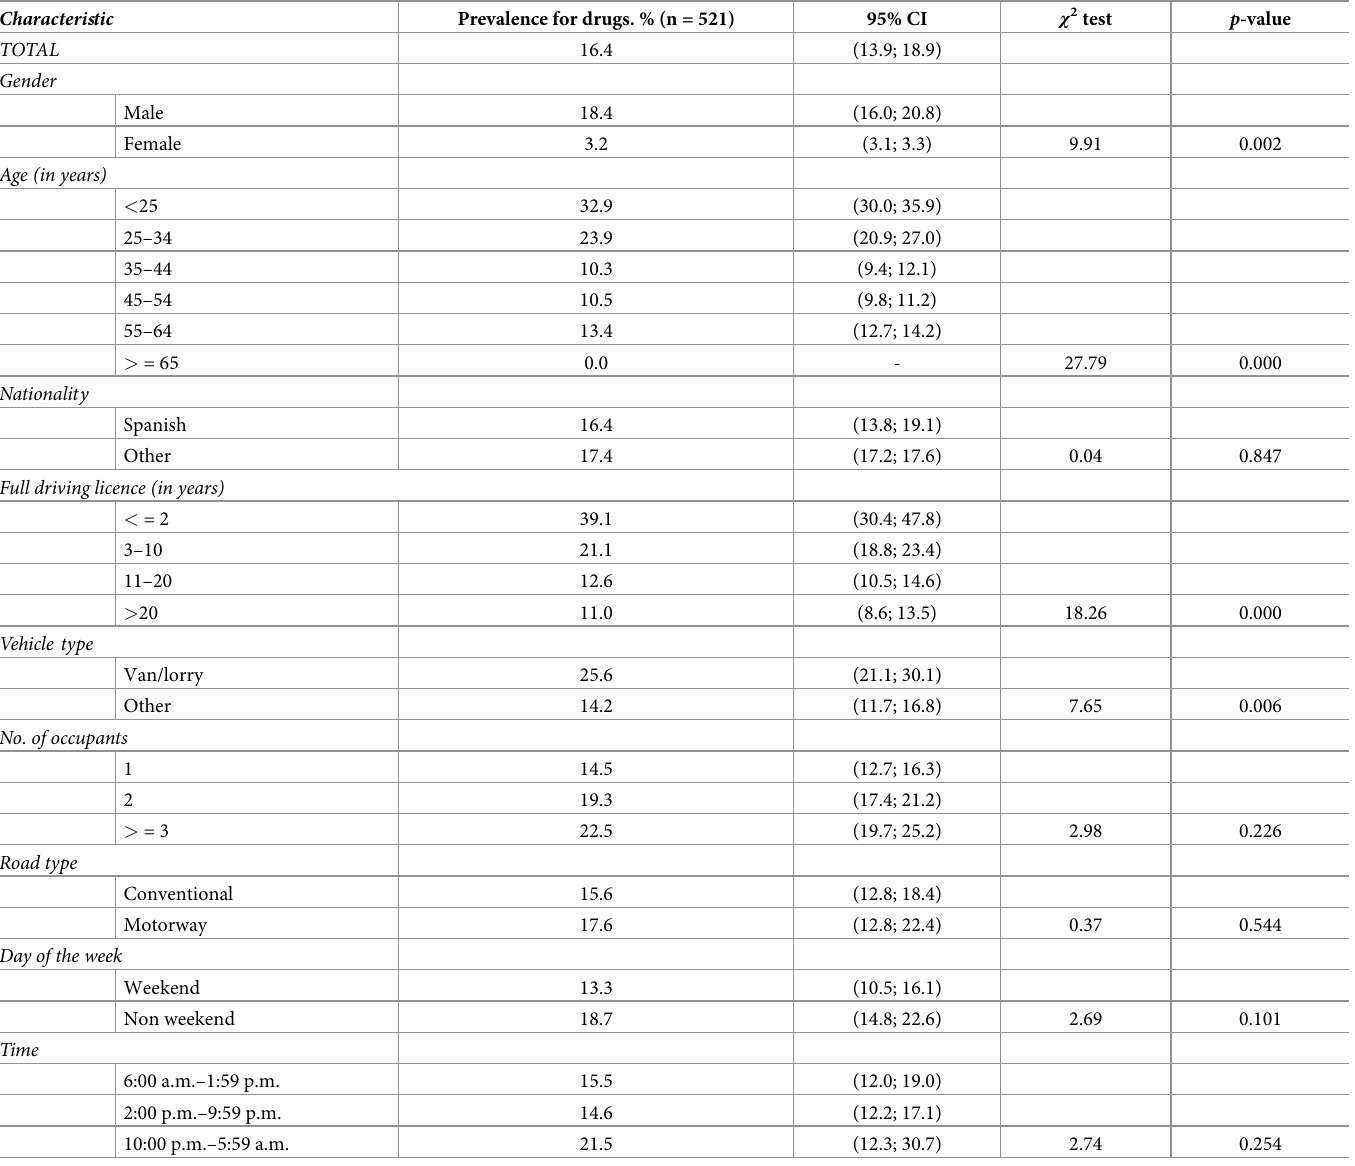
Table 2. Prevalence and 95% confidence intervals (CI) for